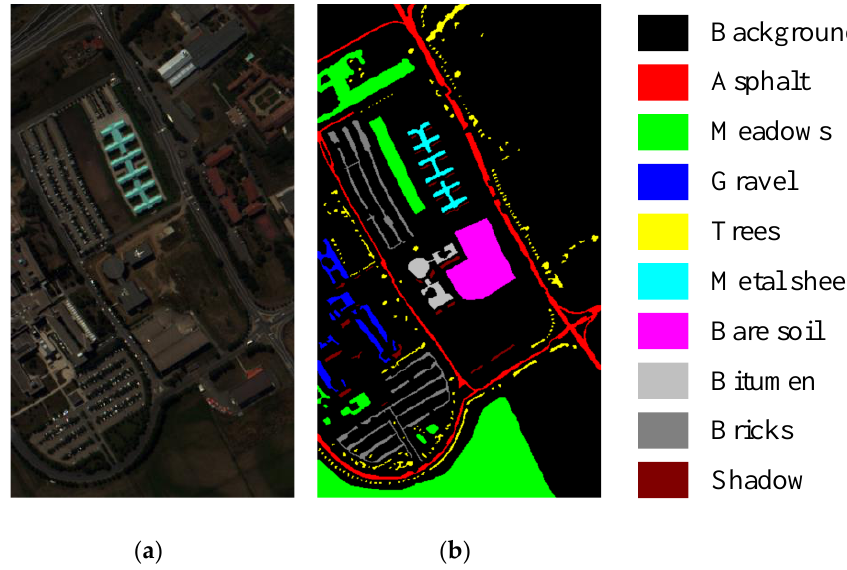
Figure 7. Pavia University dataset: ( a ) false color map, ( b ) ground truth. Table 2. Land cover classes and numbers of samples in the Pavia University dataset. Table 1. Land cover classes and numbers of samples in the Indian Pines dataset.